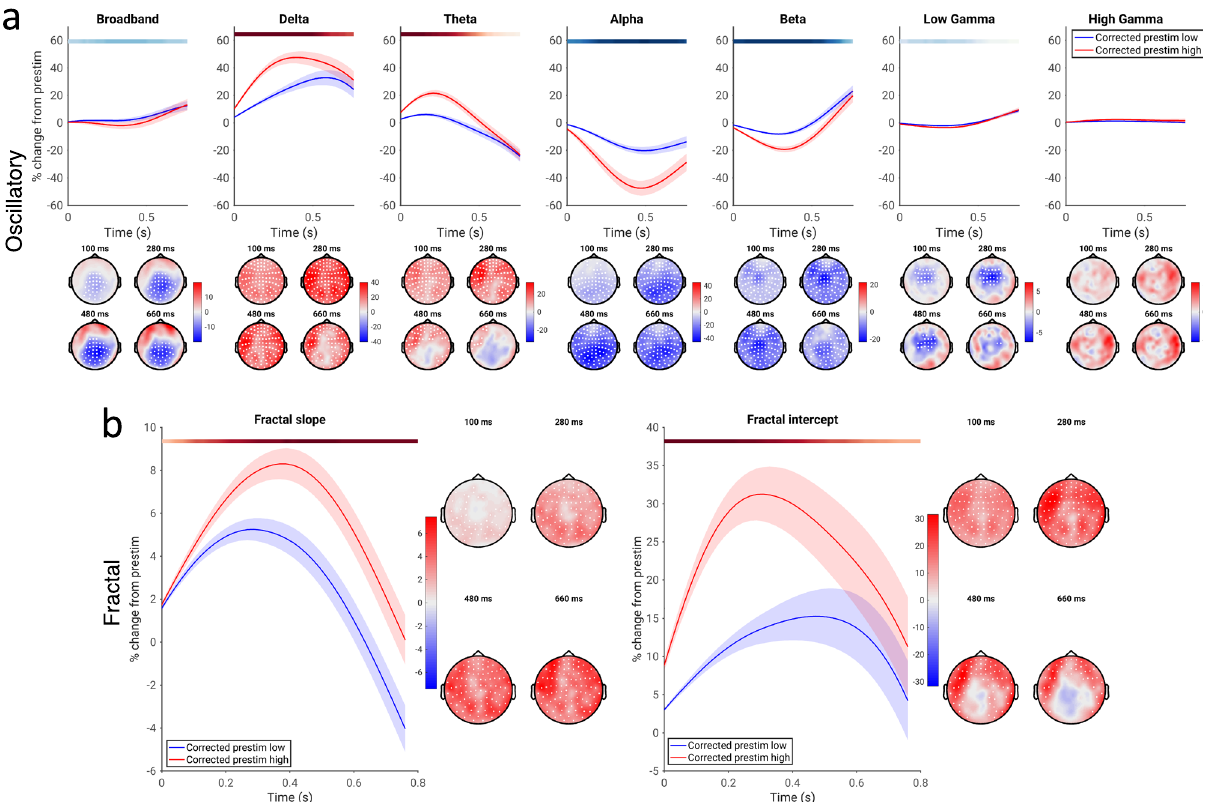
Fig. 5 Relationship of spontaneous and evoked activity for oscillatory and fractal components of the power spectrum, assessed using the method of pseudotrials. a Pseudotrial-corrected time courses for oscillatory power in high prestimulus (red) and low prestimulus (blue) conditions. Line shows mean across all sensors and subjects, shaded area indicates standard error of the channel-average time course across subjects. Effect topographies are shown at 100 ms, 300 ms, 500 ms, and 700 ms; white dots indicate sensors which are part of a signi fi cant cluster. Shaded overbars indicate the signi fi cance of the difference between prestim high and low conditions. The shade of the bar indicates the percent of sensors which are part of a signi fi cant cluster at any given time point (i.e., darkest = all sensors part of cluster, lightest/white = no sensors part of cluster); red indicates positive clusters (prestim high > prestim low), blue indicates negative clusters. b As a , but for two parameters of scale-free activity: the slope (i.e., scaling exponent) and intercept (i.e., broadband offset). N = 49